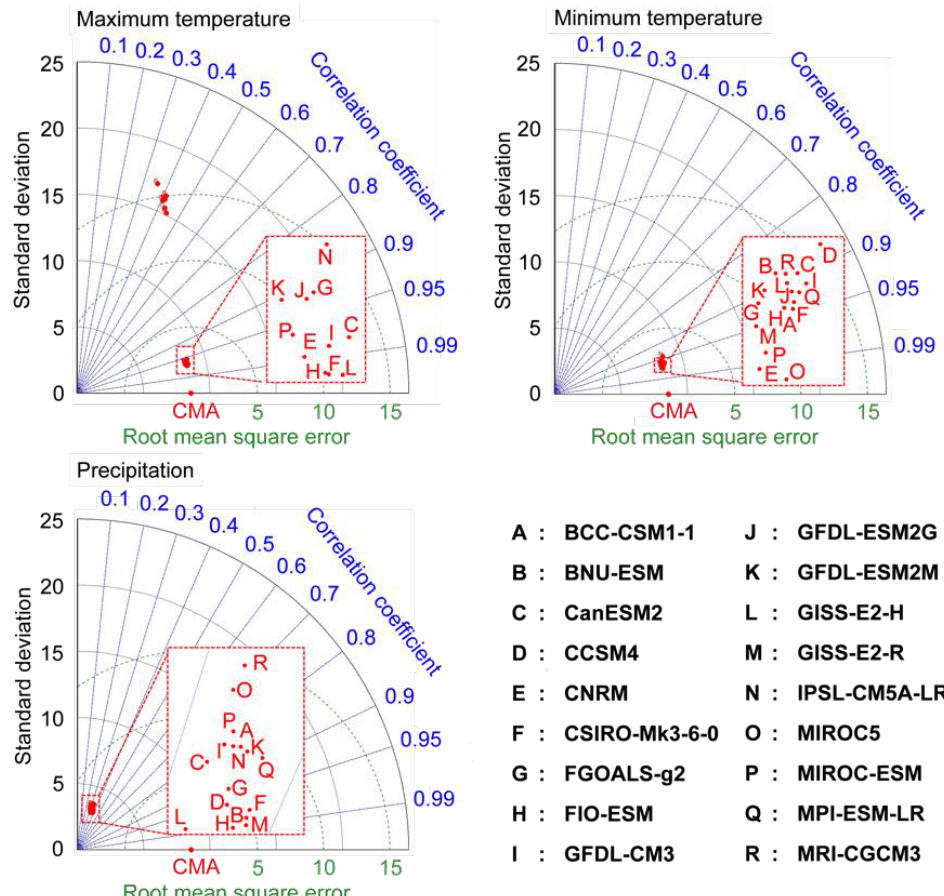
Figure 2. The Taylor diagram of the monthly maximum temperature, minimum temperature, and precipitation simulated by the 18 GCM models.